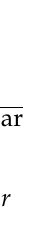
Figure 2. Spellout: English regular and irregular plurals. √ √ When the root in (S) in Figure 2 is mouse, the exponent mice spells out the entire plural S-span, on the basis of the Superset Principle (see (14) below). In fact, so long as the Insertion Heuristic does not activate Subsect S-span, mice is the only candidate for insertion, given that it alone contains a superset of (S). Exponents like mice are what Baunaz √ √ and Lander (2018, p. 34) refer to as ‘idiomatic plurals’. When the root in (S) is car, no exponent has an L-span containing a superset of the nodes. On these grounds, the Insertion √ Heuristic activates Subsect S-span, on which the exponent car spells out car, and the plural suffix {s} spells out the feature [#] (see (15) below). We will follow this basic approach to PD nouns with stem plural